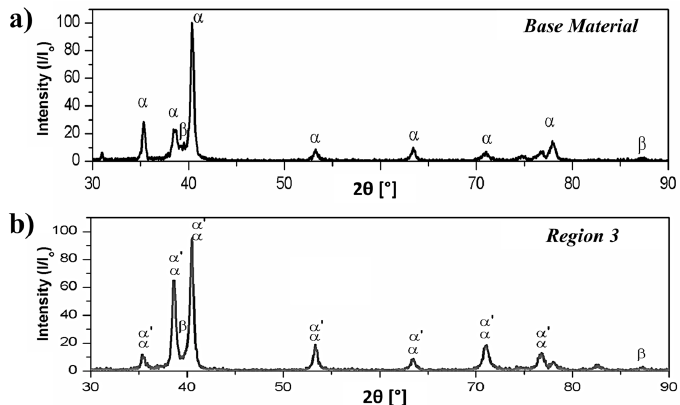
Figure 13. X-ray diffraction patterns of the ( a ) Ti-6Al-4V base material and ( b ) Ti-6Al-4V from the anchoring zone (Region 3, Figure 11b) of the Ti-6Al-4V/GF-P friction-riveted joint.